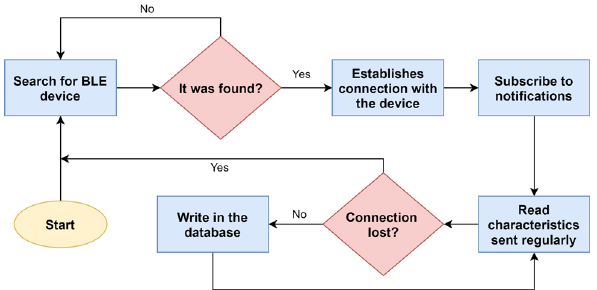
Figure 3. Flowchart for the data collection and storage tasks of the Raspberry Pi application of the original smart home